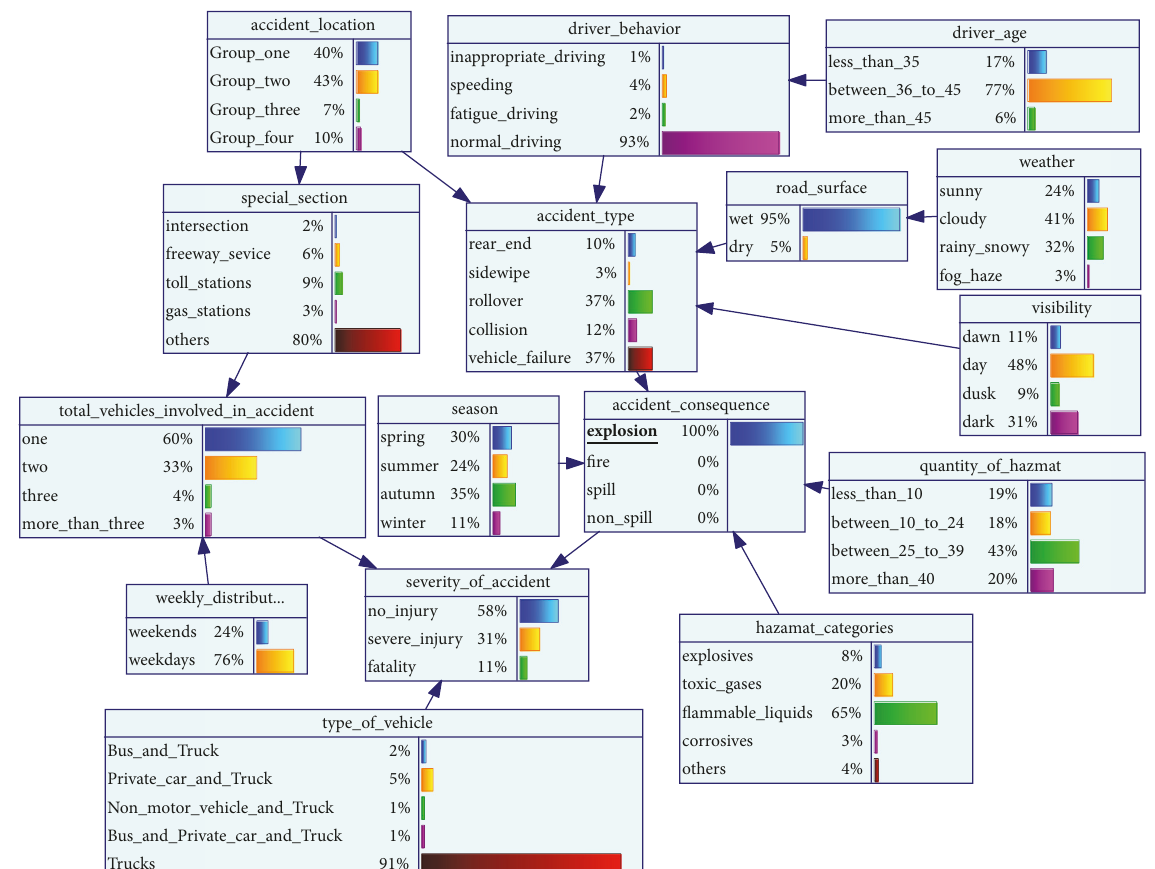
Figure 4: Posterior probability when the variable is